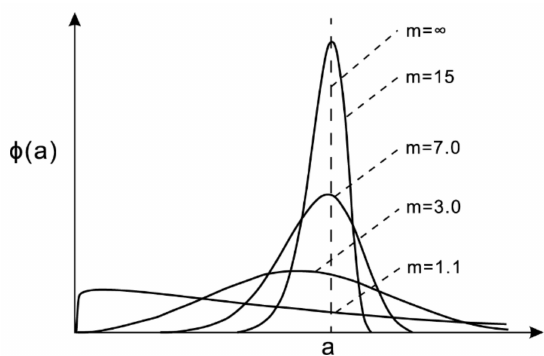
Figure 1. Weibull distribution for mechanical properties of materials with di ff erent homogeneity indexes m modified from Sharif et al.